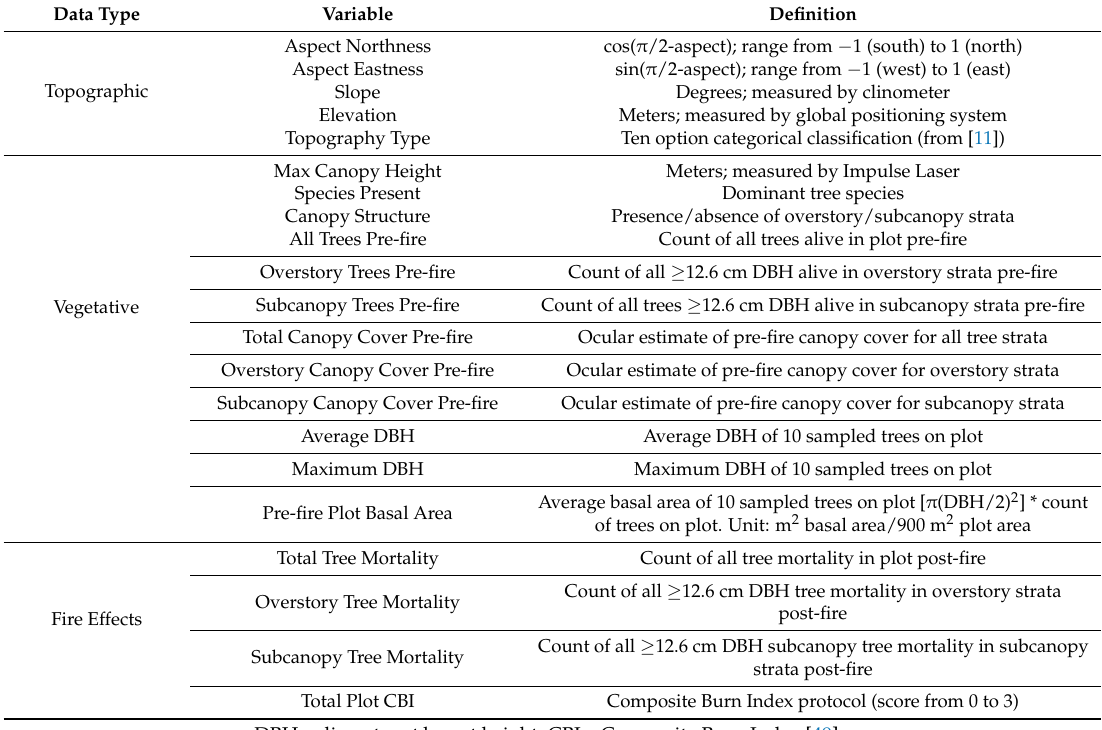
Table 1. Plot-level topographic, vegetative, and fire effects variables.